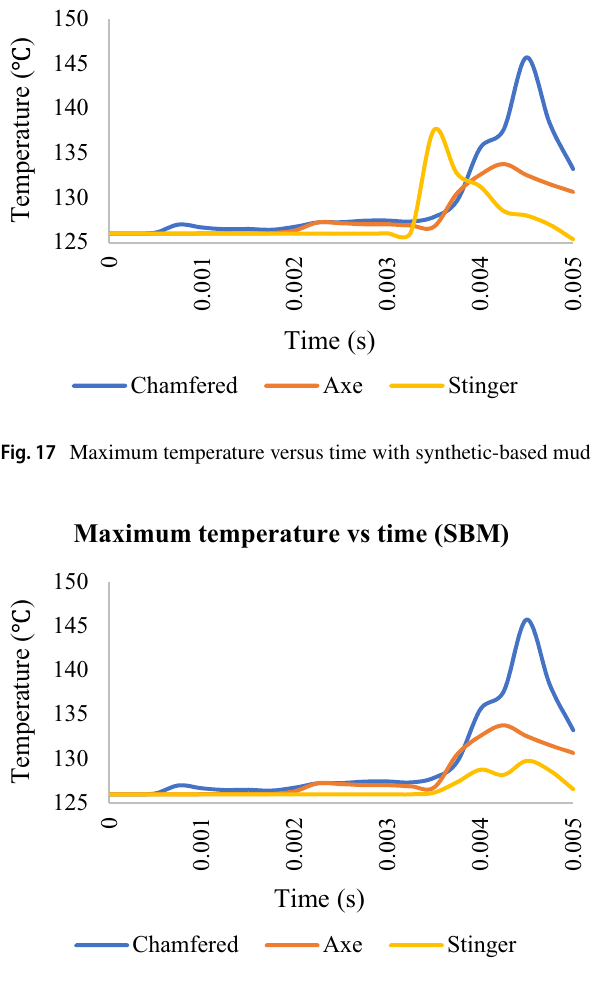
Fig. 18 Maximum temperature versus time with water-based